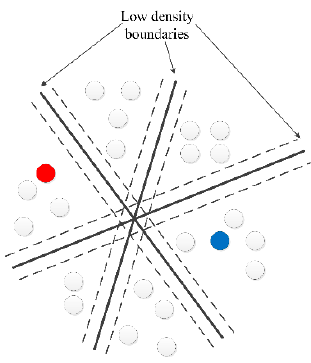
Figure 2. S4VM fault identification diagram focusing on multiple low density boundaries.